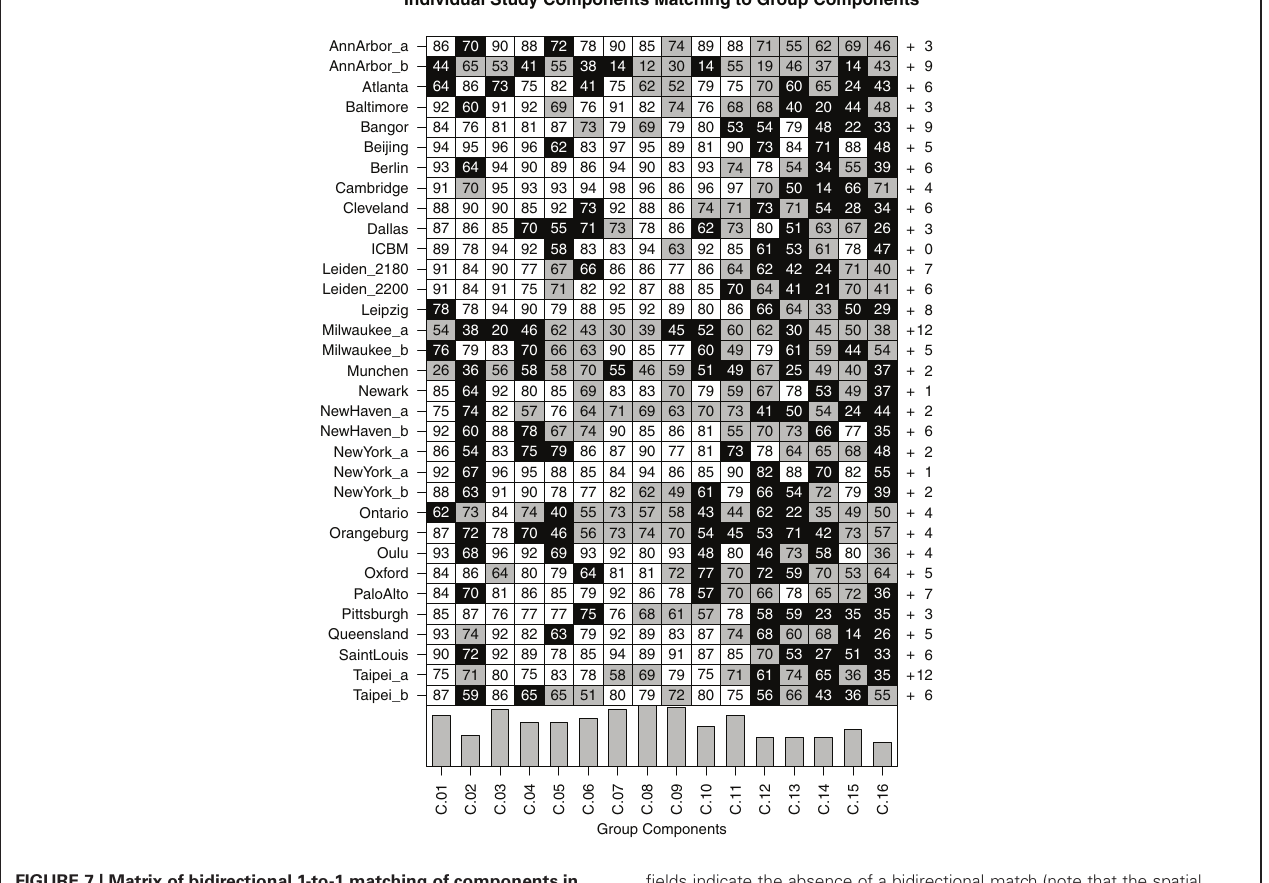
FIGURE 7 | Matrix of bidirectional 1-to-1 matching of components in individual-study analyses compared to group results from the whole dataset comprising 1000 subjects. Each field contains the spatial correlation coefficient (multiplied by 100 for readability) between the group component and the best matching individual-study component. White fields indicate a bidirectional match with a spatial correlation of at least 0.75, gray fields indicate bidirectional matches with lower spatial correlation, and black